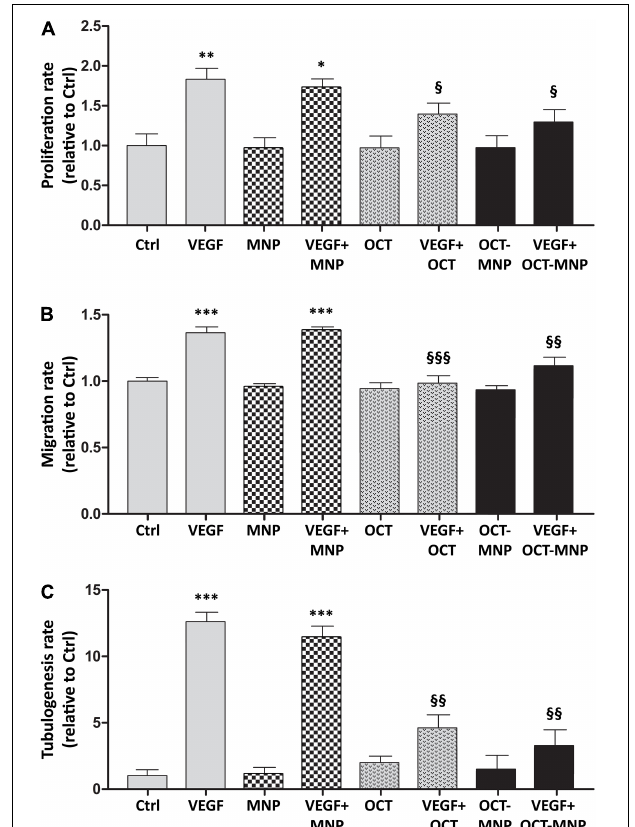
FIGURE 2 | Proliferation (A) , migration (B) , and tubulogenesis (C) of HRECs in control (Ctrl) conditions or in the presence of VEGF (40 ng/mL for proliferation, 80 ng/mL for migration and tubulogenesis) with or without 4,9 µ g/mL MNPs, 1 µ M OCT or 1 µ M MNP-OCT. Values are plotted as means ± SEM. * p < 0.05, ** p < 0.01, and *** p < 0.001 vs. Ctrl; § p < 0.05, §§ p < 0.01 and §§§ p < 0.001 vs. VEGF; n =